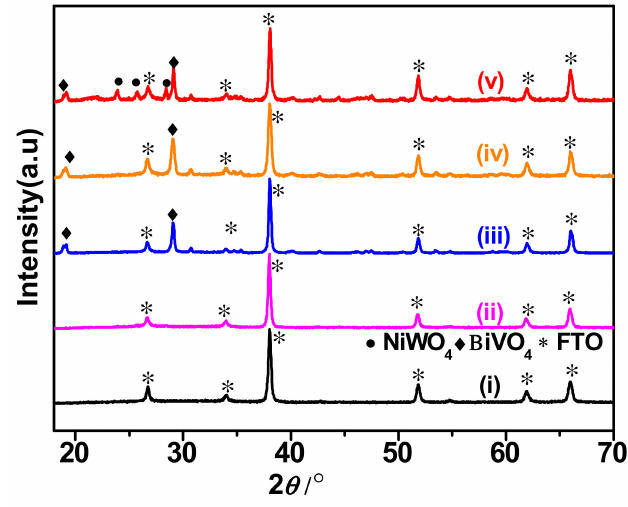
Figure 2. Normalized X-ray di ff raction patterns for ( i ) FTO electrodes, ( ii ) SnO 2 loaded FTO, ( iii ) two-step electrodeposited BiVO 4 / FTO photoanodes, ( iv ) BiVO 4 / SnO 2 loaded over FTO, and ( v ) NiWO 4 / BiVO 4 / SnO 2 loaded over